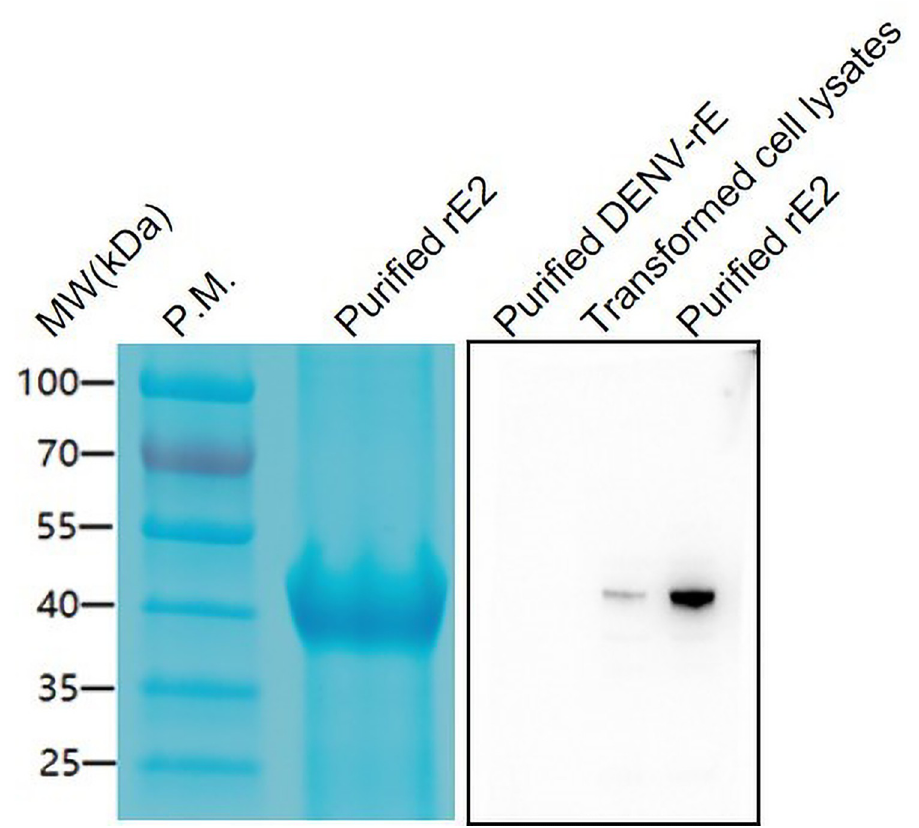
Fig 1. SDS-PAGE and immunoblot analysis of CHIKV rE2 protein produced in E. coli. MW(kDa), Molecular weight (kilodaltons); P.M., Prestained protein marker; purified rE2, recombinant CHIKV rE2 protein after purification by Ni- NTA column chromatography; purified DENV-rE, purified recombinant extracellular domain of E protein from dengue virus type 2; Transformed cell lysates, BL21 DE3 E. coli cells were transformed with pET-30a-CHIKV-rE2 plasmid without inducing with